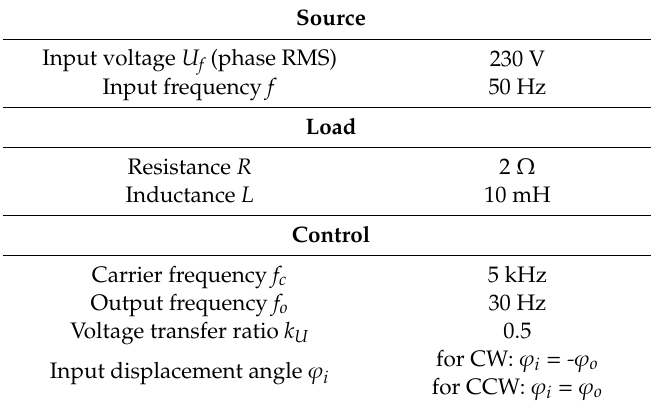
Table 3. Parameters of the three-to-nine-phase MC simulation